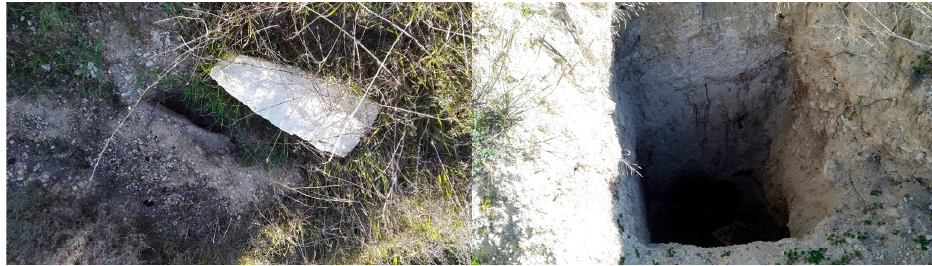
Figure 3. Looted tombs (February 2016).